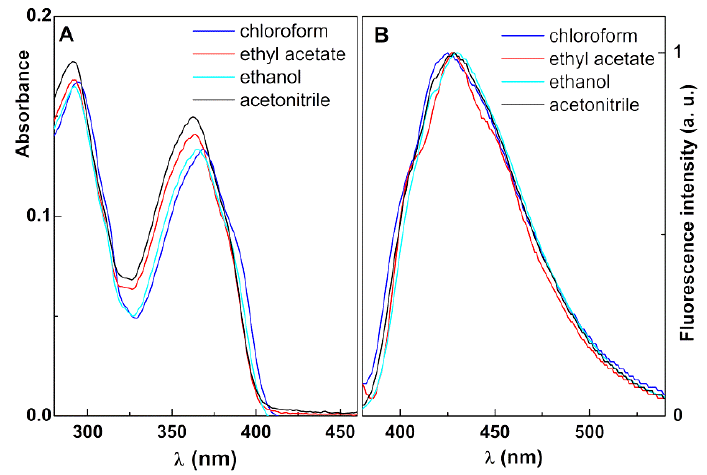
Figure 3. ( A ) Absorption spectra of 1 × 10 − 5 M solutions of compound 1 in ethyl acetate, acetonitrile, chloroform, and ethanol. ( B ) Normalized fluorescence spectra ( λ exc = 370 nm) of 1 × 10 − 6 M solutions of compound 1 in the same solvents.